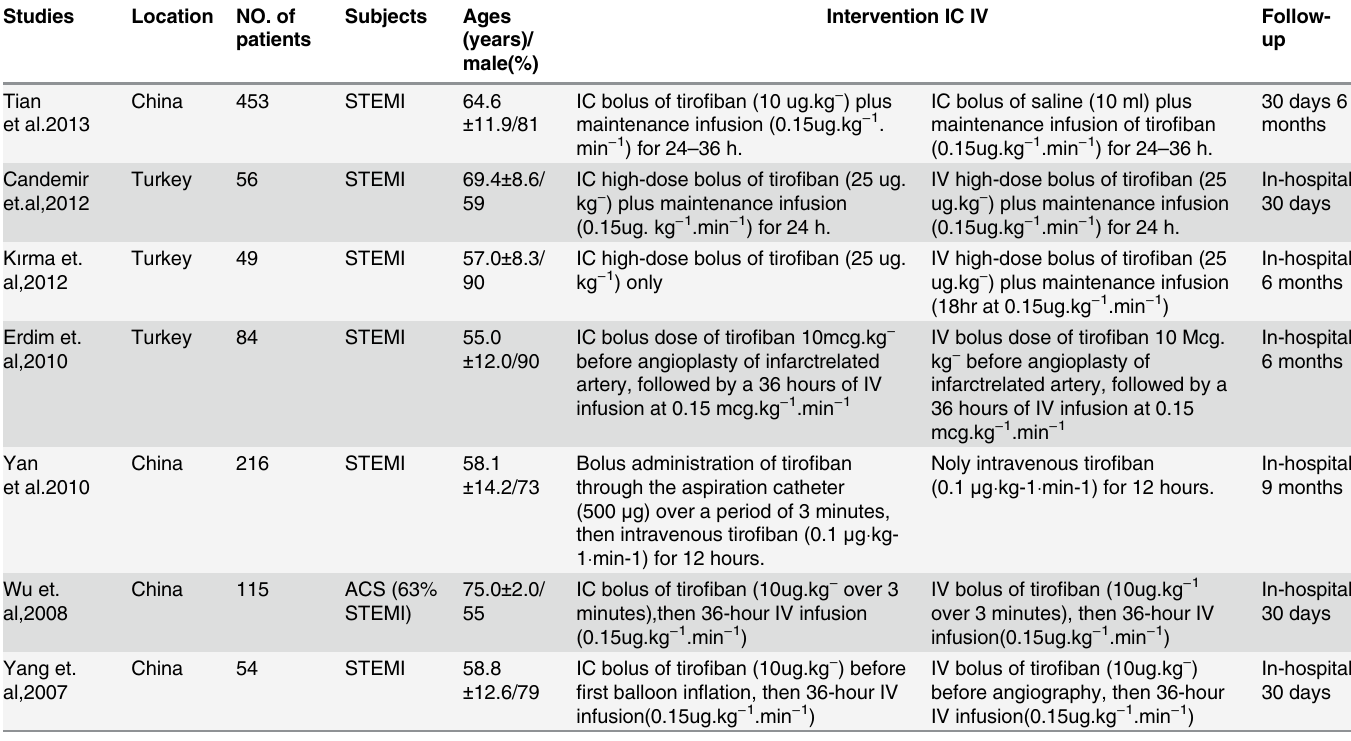
Table 2. Characteristics of patients and interventions in included